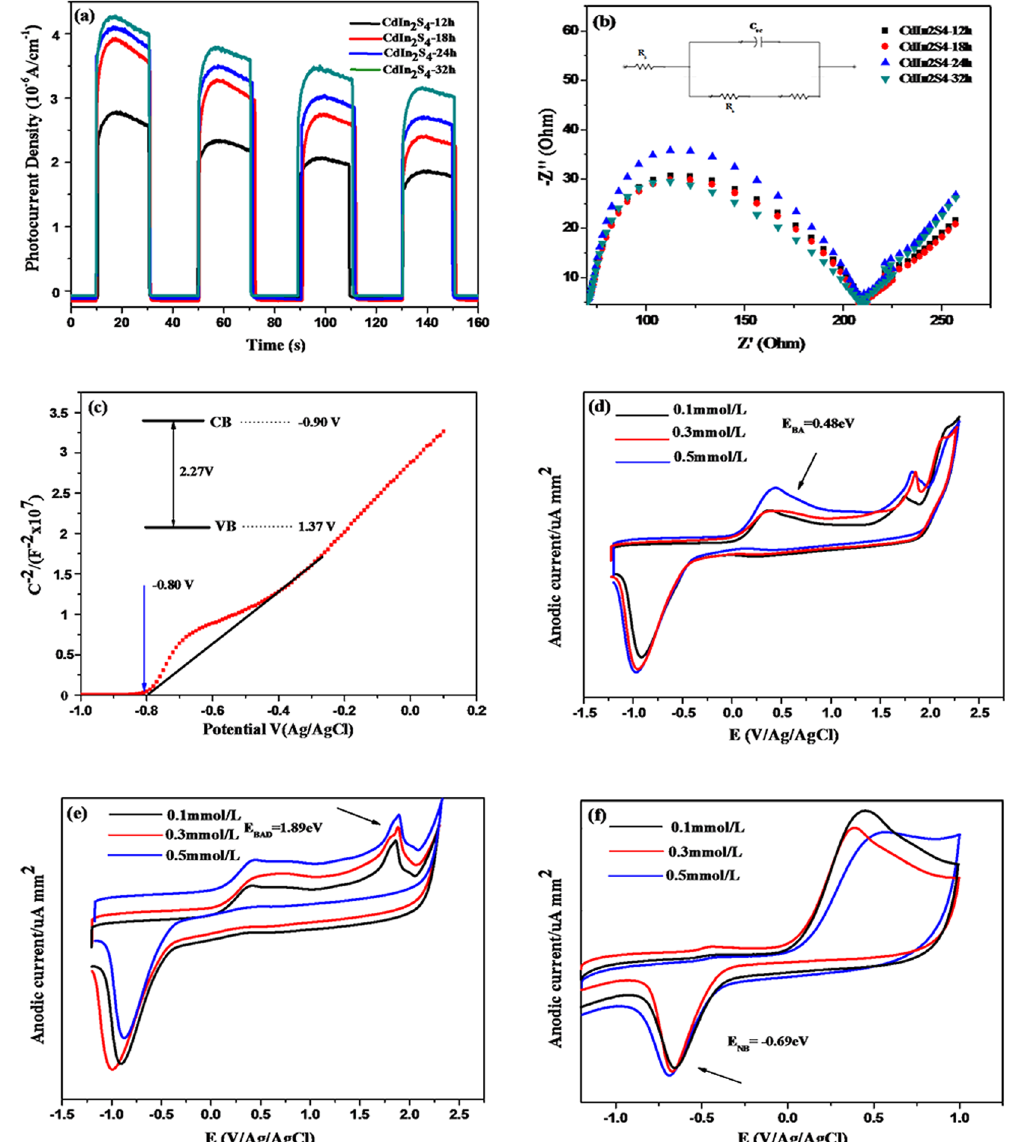
Figure 13. The photocurrent transient response of the samples in a 0.2 M Na 2 SO 4 aqueous solution without bias versus Ag/AgCl electrode under visible light irradiation ( a ). EIS Nyquist plots of CdIn 2 S 4 photocatalysts synthesized at different time in 0.1 M KCl solution containing 0.1 M K 3 [Fe(CN) 6 ]/K 4 [Fe(CN) 6 ] ( b ). (Inset: Electrical equivalent circuit used for fitting of impedance spectra, R S , C SC , R b and W represent electrolyte resistance, space charge capacitance, bulk electrode resistance and Warburg impedance, respectively.) Mott- Schottky plots for the CdIn 2 S 4 electrodes ( c ). The cyclic voltammogram of BA ( d ), BAD ( e ), and NB ( f ) with different concentrations (0.1, 0.2 and 0.5